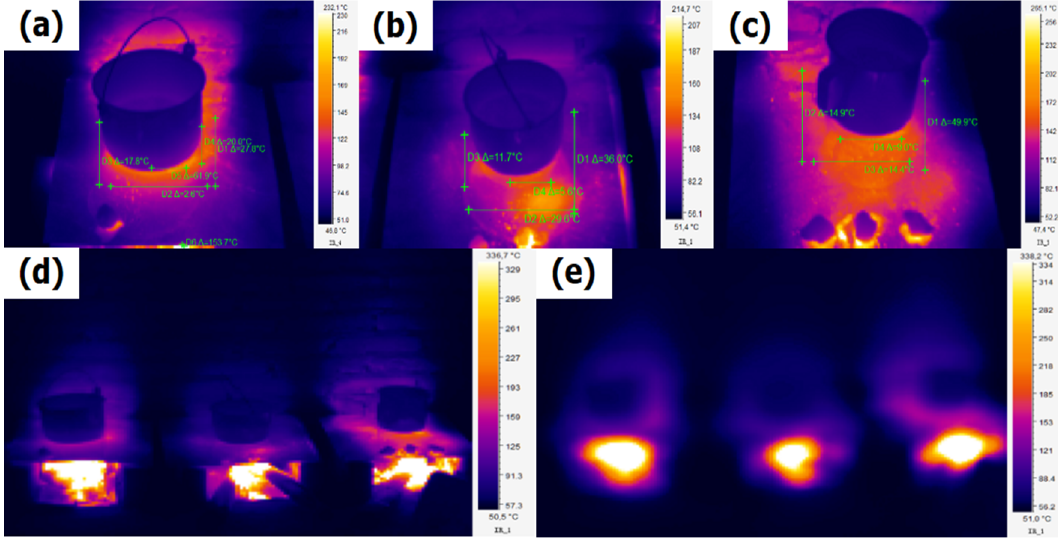
Figure 12. Combustion at 70 min: ( a ) briquette; ( b ) pine firewood; ( c ) oak firewood. ( d ) Integrated image of the three fuels; ( e ) emissions in the form of radiant bodies from the three fuels.